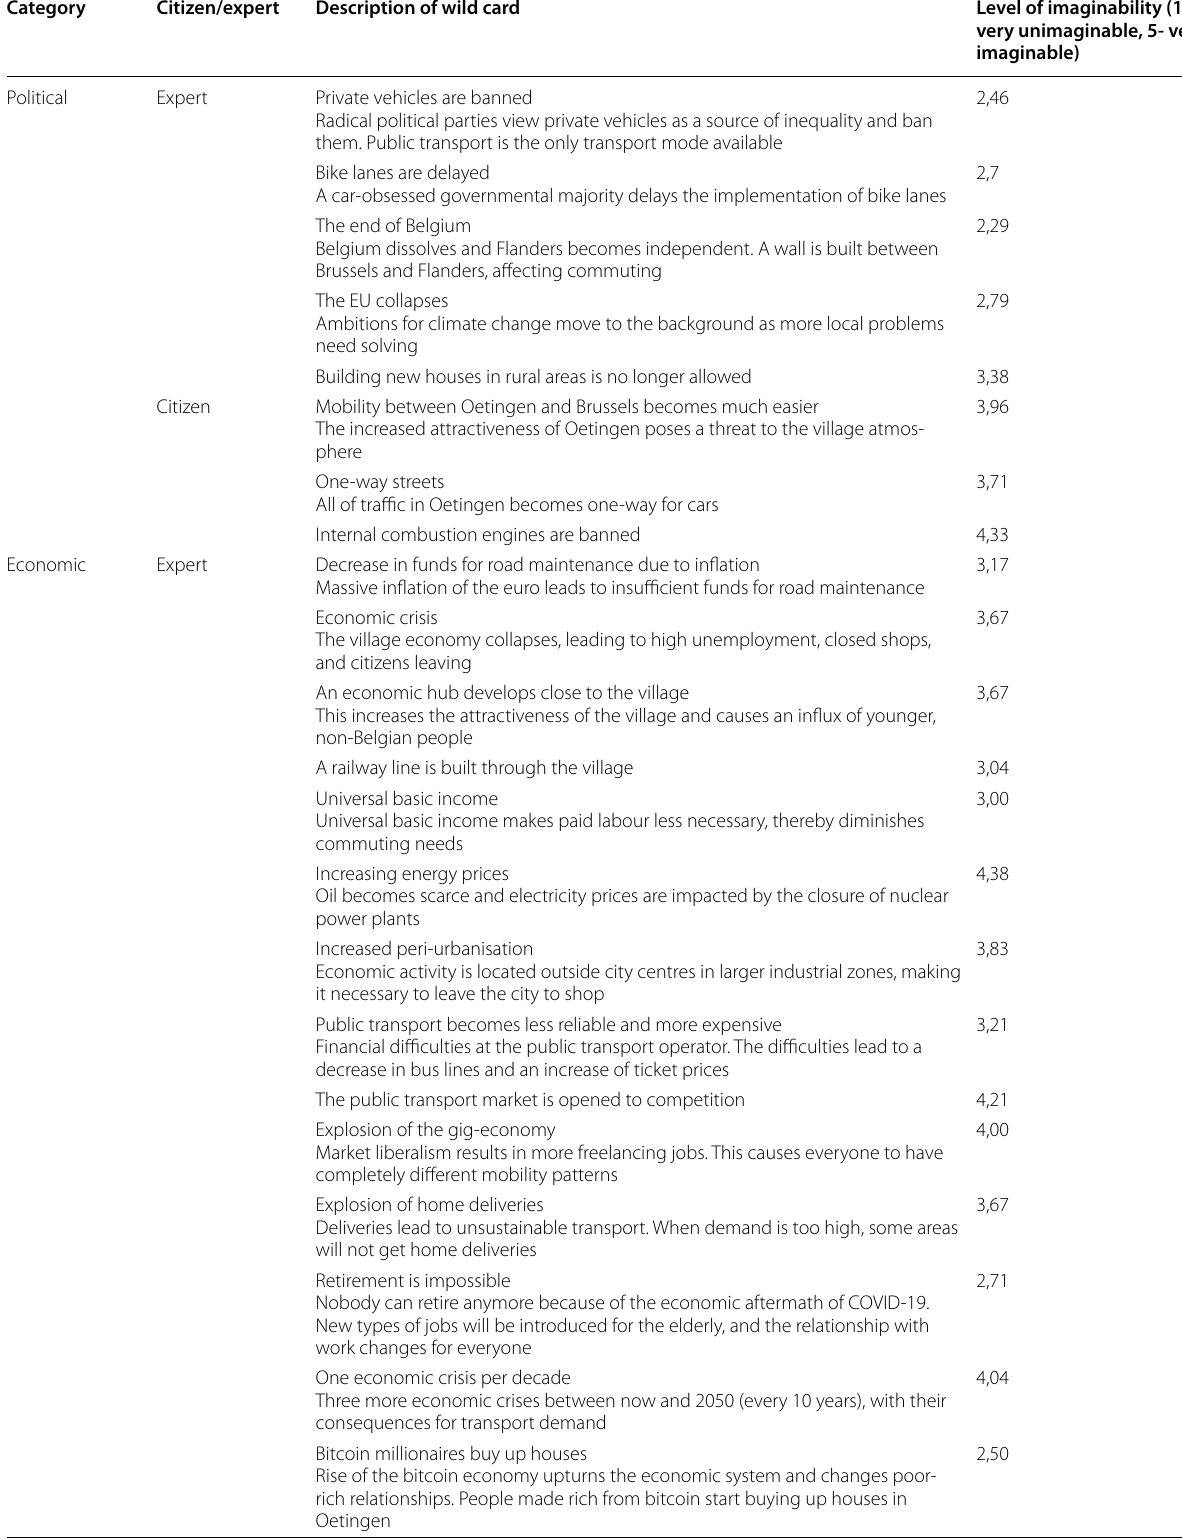
Table 4 Selected wild cards developed by experts and citizens